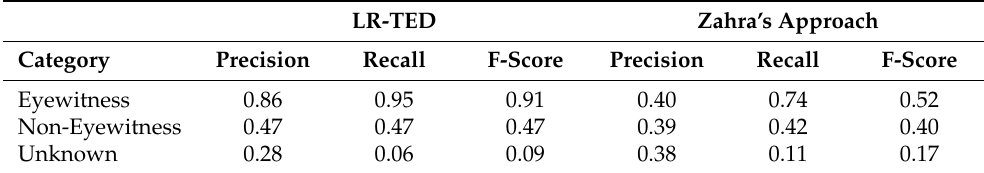
Table 15. A comparative analysis of the ANN